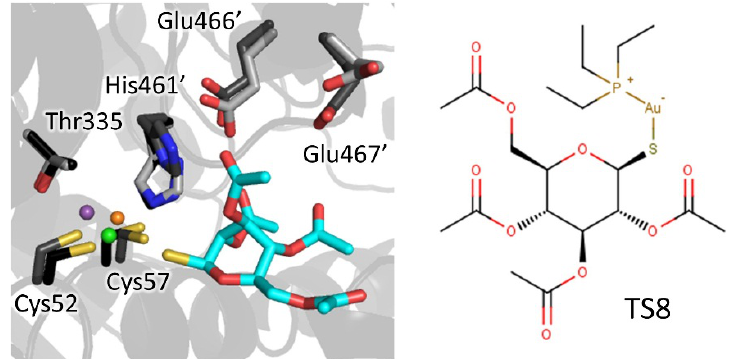
Figure 8. Metal complexation: Sb(III) (violet) forms a stable complex with catalytic residues. Similarly, Au(I) (orange) displays a planar-trigonal coordination (Ilari et al., 2012) with Cys52, Cys57, and a chloride ion (green). The thiosugar moiety (cyan) participates in the inhibition mechanism interacting with His466′, Glu466′, and Glu467′. Residues are shown as sticks, light grey for inhibitor-free TR (PDB: 2jk6), dark grey for Au-bound TR (PDB: 2yau), and black for Sb-bound TR (PDB: 2w0h).